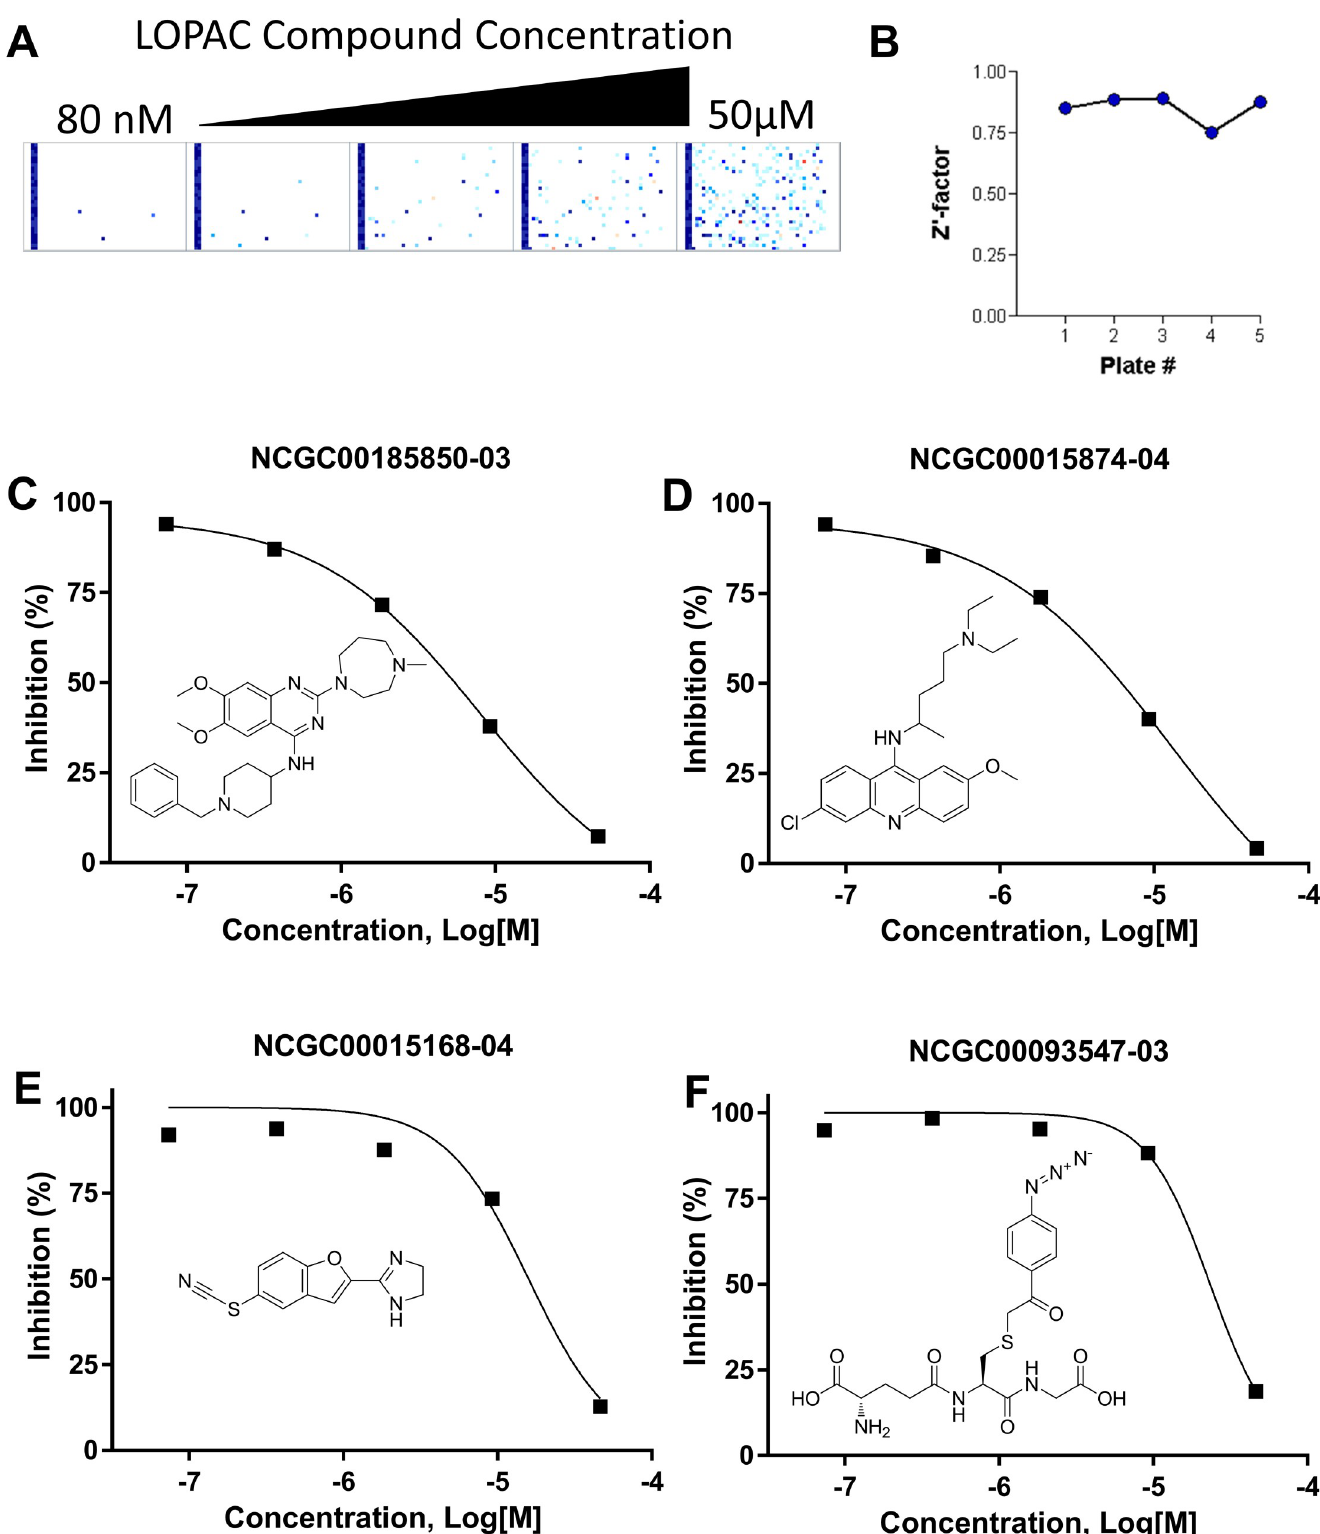
Fig 3. Screening of the LOPAC 1280 library for WRN inhibitors. (A) Activity heatmap representation of the 1536-well plates containing the LOPAC 1280 screen compounds, each plate rectangle corresponding to a different concentration (80 nM, 400 nM, 2 μ M, 10 μ M and 50 μ M) of compound. Individual dots represent inhibition of GST-WRN 500-946 (20 nM) unwinding of the FORKF DNA substrate (100 nM) by a compound at that particular concentration. (B ) Z’-factor for each